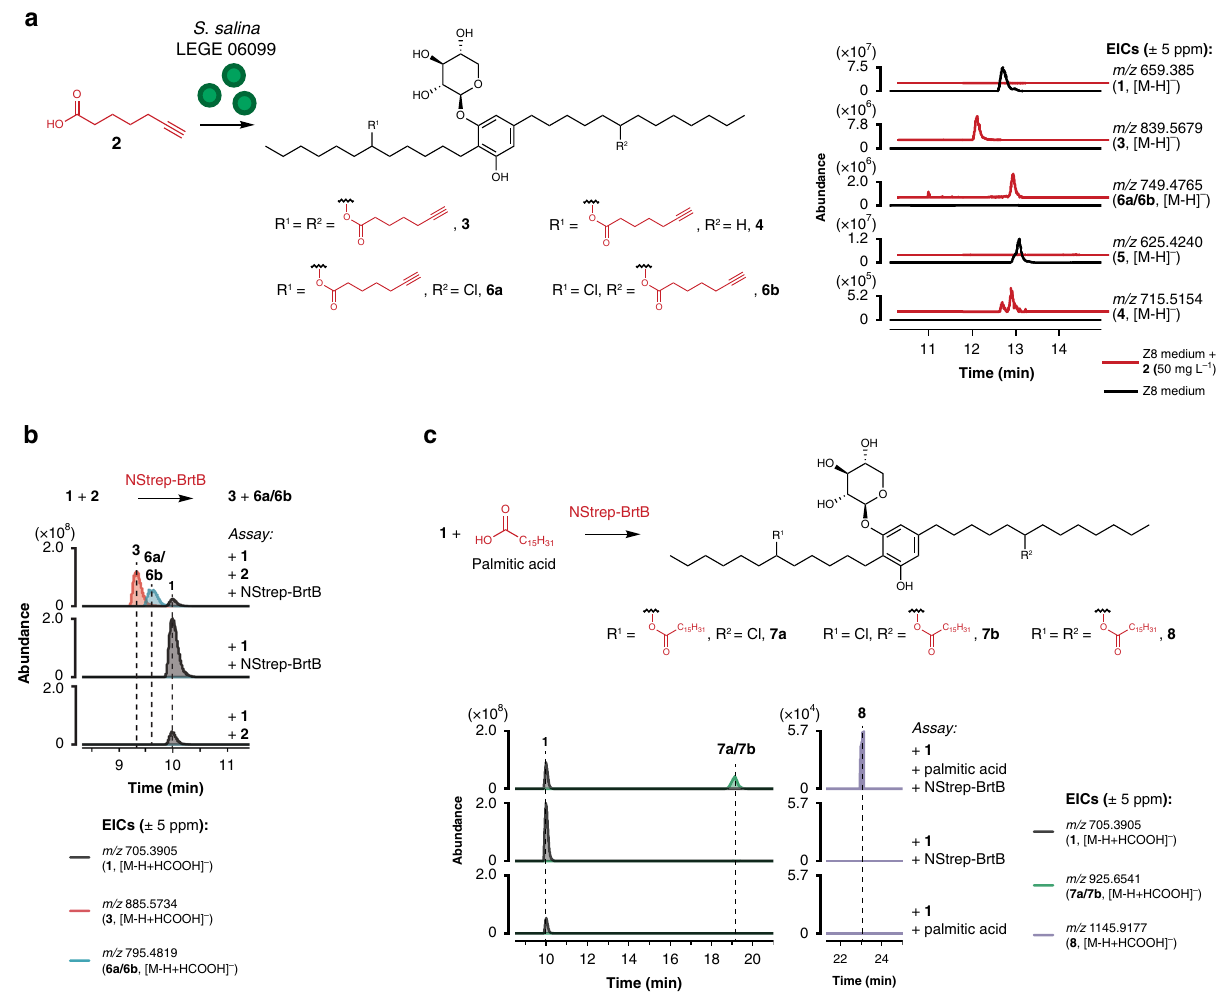
Fig. 2 Bartoloside-fatty acid esters are formed in vivo and in vitro by BrtB. In cultures of S. salina LEGE 06099 supplemented with 50 mg L − 1 of 6- heptynoic acid ( 2 ), formation of the bartoloside esters 3 , 6a / 6b and 4 with concomitant depletion of the corresponding bartolosides (A, 1 or G, 5 ) was observed by LC-HRESIMS ( a ). Analysis (LC-HRESIMS) of the NStrep-BrtB-mediated O-alkylation of bartoloside A ( 1 ) with 2 to generate diester 3 and monoesters 6a / 6b ( b ) or with palmitic acid to generate monoesters 7a / 7b and diester 8 , the latter in much lower amount ( c ). Full reactions